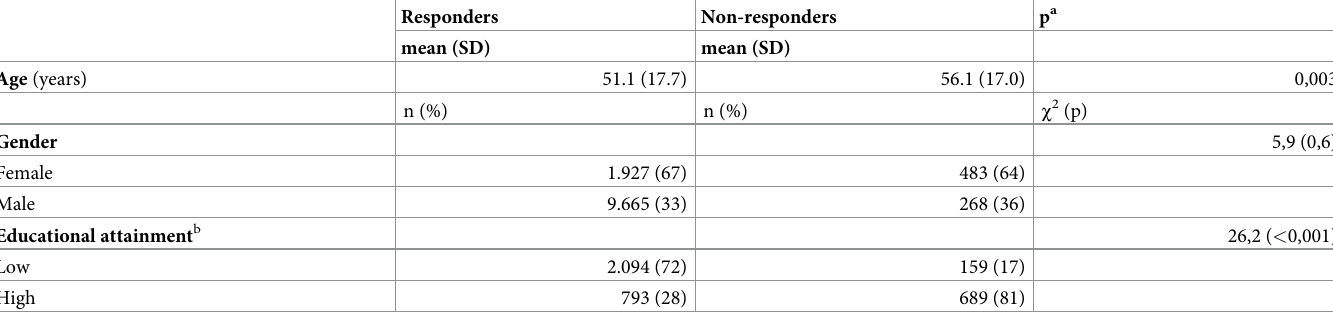
Table 3. Demographic characteristics of responders and